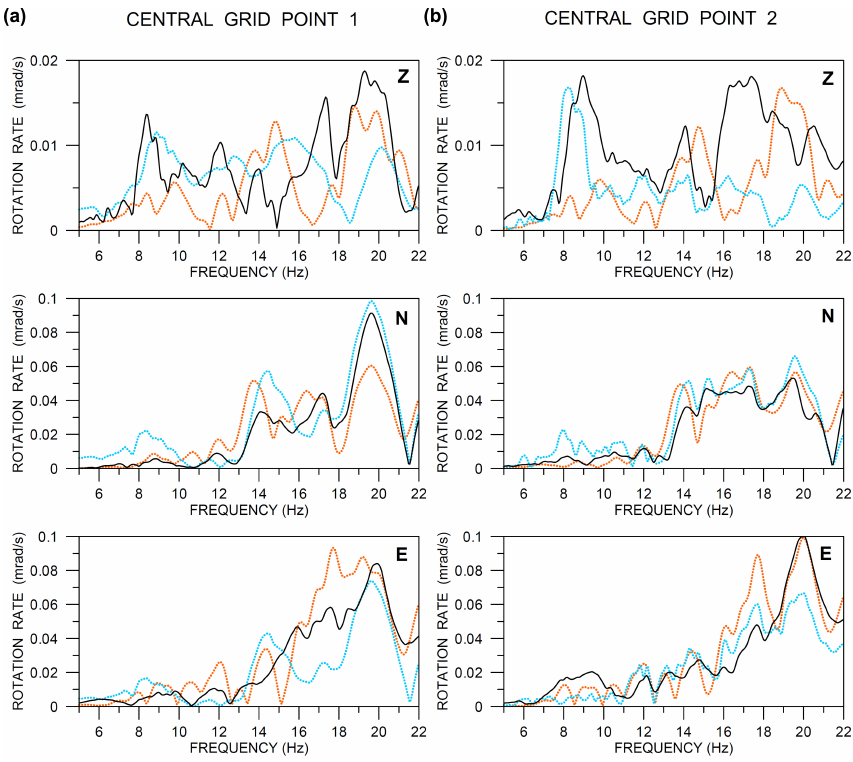
Figure 17. Comparison of the ADR (dotted orange), Rotaphone (solid black), and R-1 amplitude spectra (moduli) of three rotation rate components (vertical Z, North N, and East E) at the central grid points 1 ( a ) and 2 ( b ). Data are band-pass filtered between 6 and 20 Hz and instrument-corrected. The sampling frequency was 250 Hz. The Rotaphone and ADR amplitudes are real. The amplitudes of the R-1 records are multiplied by the following normalizing factors (the same as in Figure 16): 10 (Z), 5 (N), 2 (E) in part ( a ), and 1 (Z), 1.8 (N), 1 (E) in part ( b